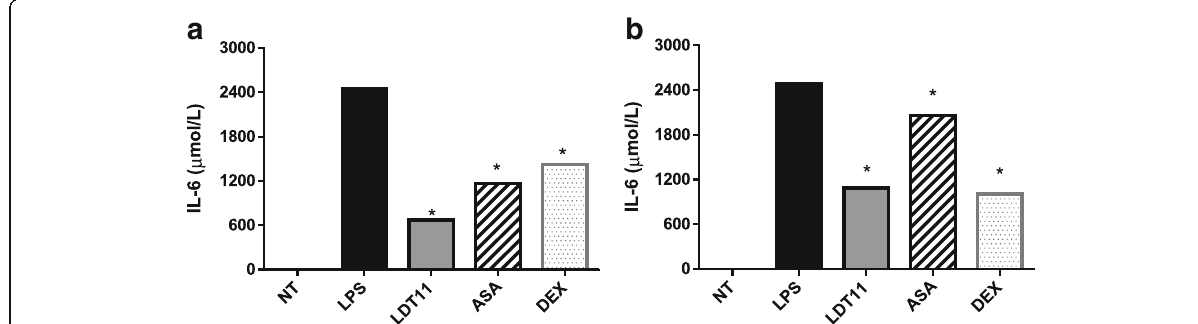
Fig. 12 Evaluation of the potential immunoprotective effect of the CNSL derivatives by measuring the levels of cytosine IL-6 production in the supernatant at 6 h ( a ) and 24 h ( b ) post-stimulus. NT- untreated cells; LPS - LPS-stimulated cells; LDT11 - cells treated with LDT11 and then with LPS; AAS - cells treated with commercial acetylsalicylic acid and then with LPS; DEX - cells treated with the commercial anti-inflammatory Dexamethasone and then with LPS. All data are from at least three independent experiments, * p < 0.05, statistically different compared with cells